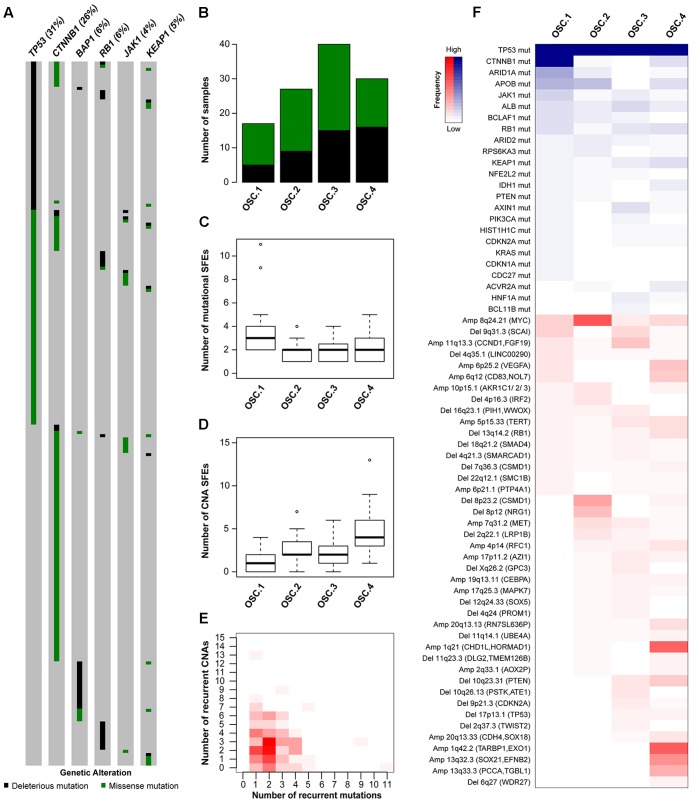
Oncogenic signature classes in TP53-mutant hepatocellular carcinoma. The pattern of mutations in TP53, CTNNB1, BAP1, RB1, JAK1 and KEAP1 in hepatocellular carcinoma (A). Number of TP53-mutant samples classified as OSC1, OSC2, OSC3, and OSC4, according to the color key in A (B). Number of mutational (C) and copy number (D) ‘selected functional elements’ (SFEs) in the different subclasses. The distribution of mutational vs copy number SFEs in TP53-mutant cases (E). The shade of red is proportional to the number of samples for a given (x,y) position. Heatmap shows the mutational and copy number SFEs altered in at least 5% of the samples in at least one oncogenic signature class (F). Shades of red and blue are proportional to the number of samples with a given genetic alteration, according to the color key. Plot in (A) was generated using cBioPortal (http://www.cBioPortal.org) and curated manually.